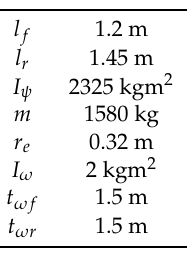
Table 1. Research vehicle and tire